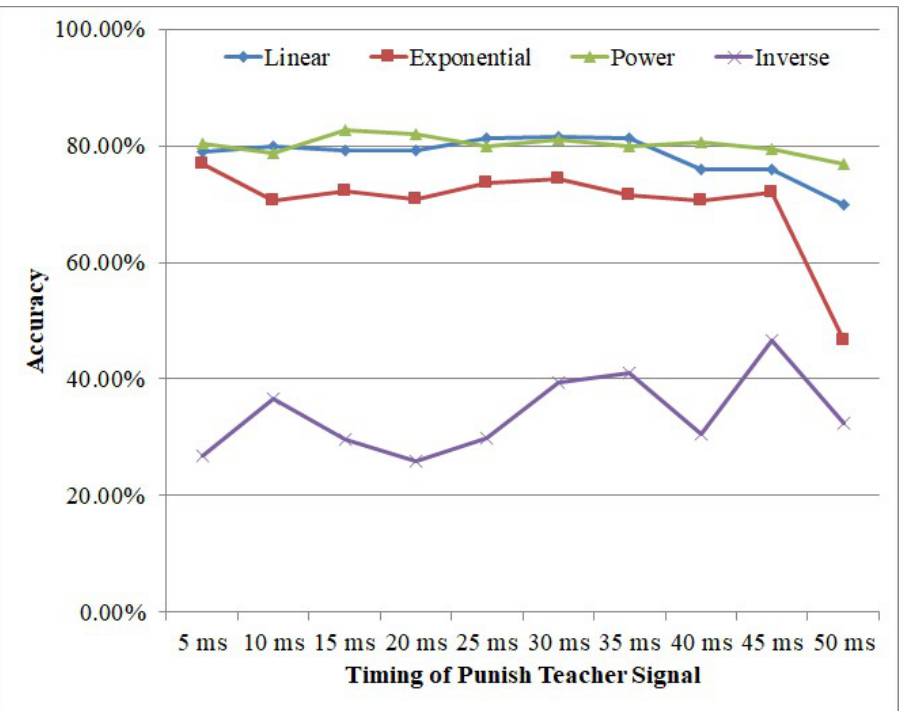
Figure 10. Influence of the timing of punishing teacher signal.